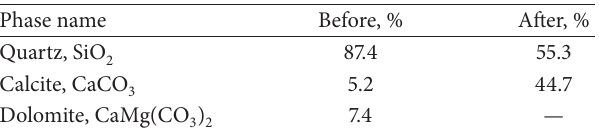
Table 11: Soil mineralogical transformations before and after treat- ment.